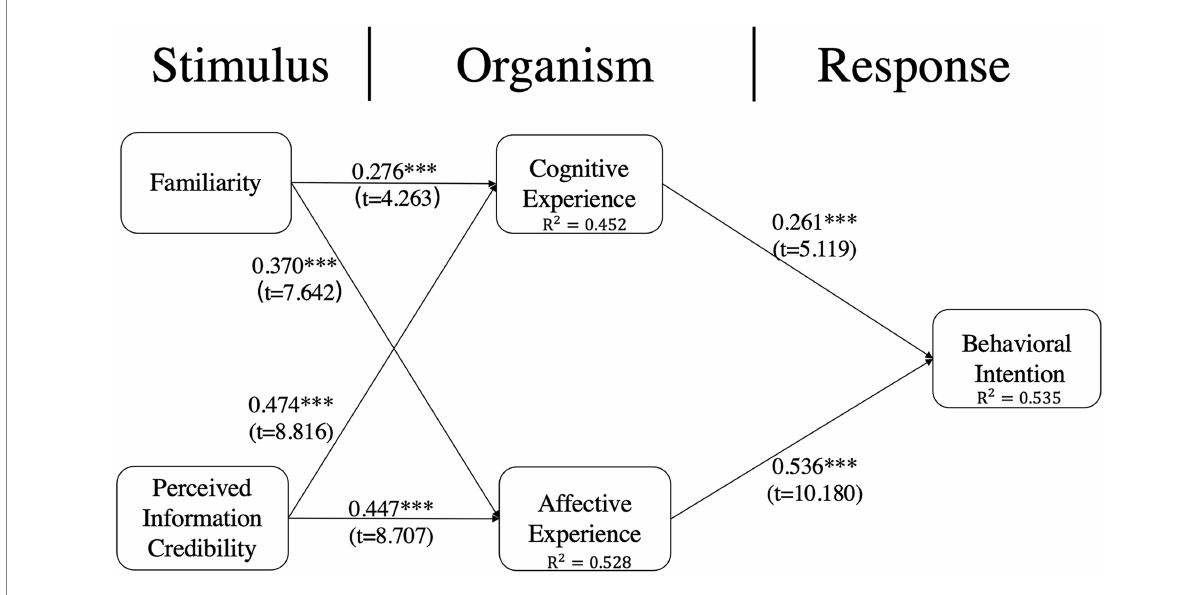
FIGURE 2 Research model Results of the structure model. * p < 0.05; ** p < 0.01; *** p <